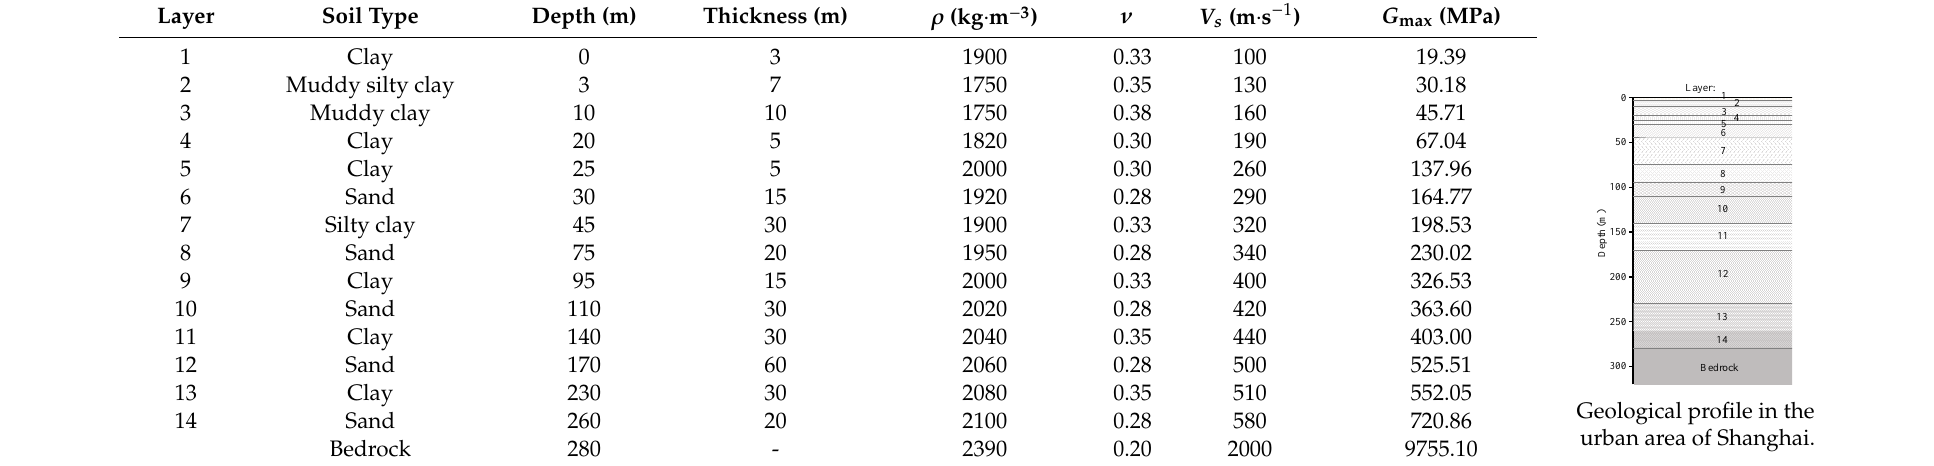
Table 3. Parameters of soil site in urban area of Shanghai. ρ : density; ν : Poisson’s ratio; V s : shear wave